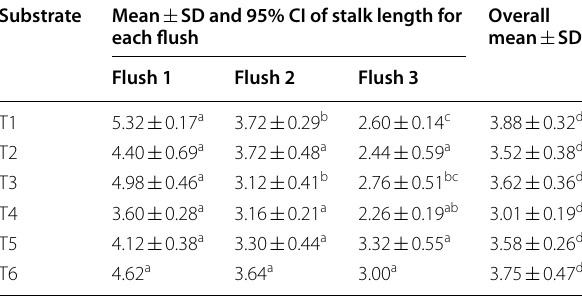
Mean values followed by different superscript letters within a row and columns are significantly different (p < 0.05)